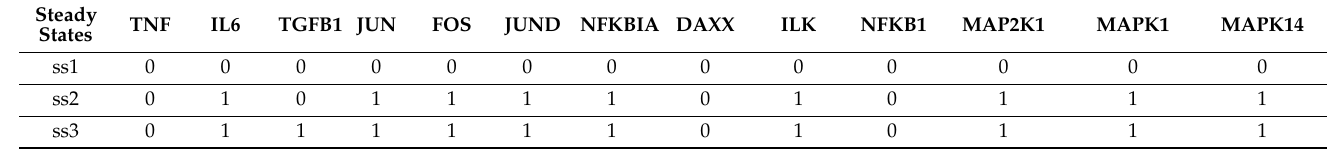
Table 7. Stable states of the Boolean network (DAXX and NFKB1 KO, input TNF =